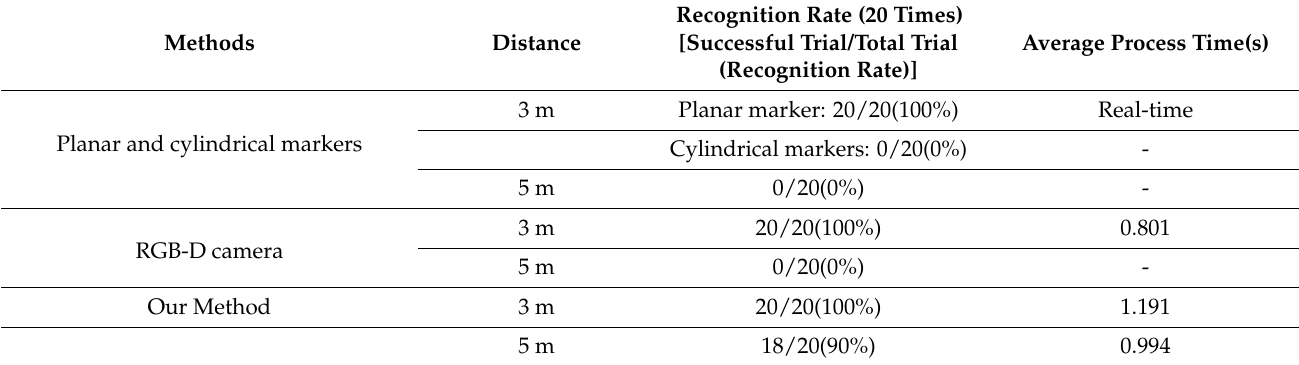
Table 1. Quantitative results for measuring recognition rate and processing time (the number of tests: twenty).